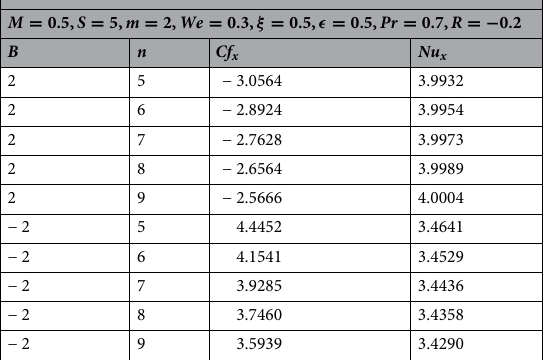
Table 2. Numeric results of skin friction and heat transfer coefficient under influence of stretching ratio and power law index impact.